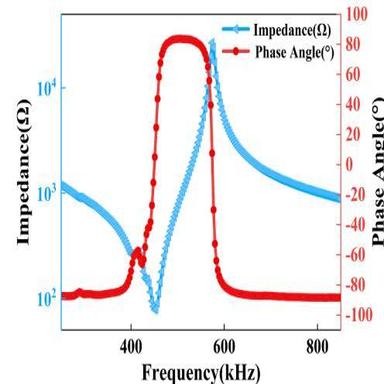
Impedance spectrum of 1–3 piezoelectric composites.